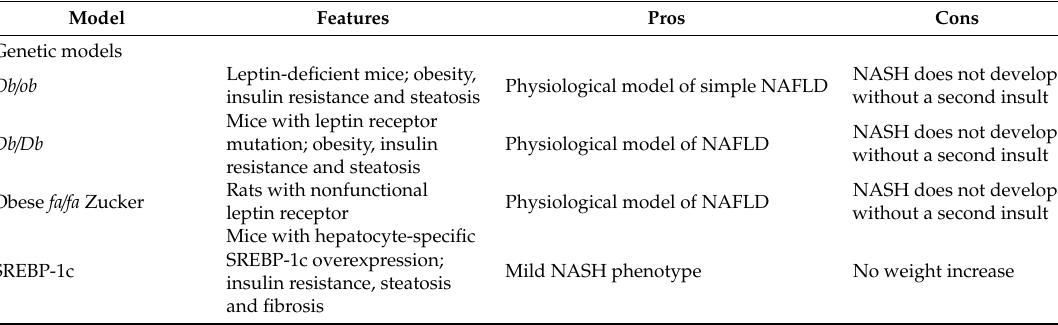
Figure 2. Mechanism of NAFLD pathogenesis in in vivo models. FA accumulation has a key role in NAFLD and NASH development. In ob / ob , Db / Db and Zucker models, a leptin-related increase in appetite results in insulin resistance and FA accumulation. HFD and fructose-rich diets induce insulin resistance and, secondarily, liposysis; HFD also causes a higher FA intake. In SREBP-c1 genetic model, FA increase is caused by a higher level of lipogenesis. MCD diet inhibits VLDL synthesis and export, as well as a GSH deficiency, leading to oxidative stress. ↑ indicates an increase. HFD, high-fat diet; SREBP-1c, sterol regulatory element-binding protein 1c; MCD, methionine and choline deficient; VLDL, very low-density lipoprotein. Table 4. In vivo experimental models for the study of NAFLD and